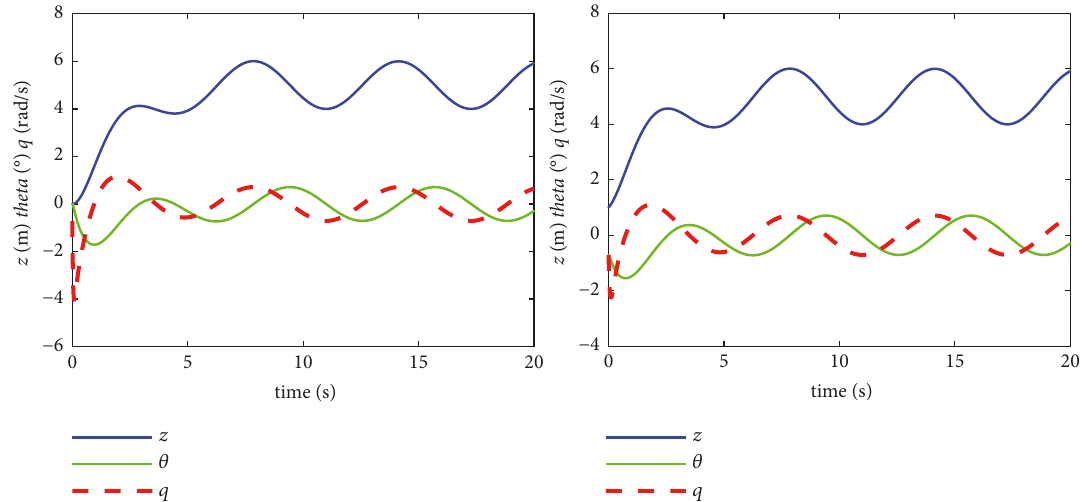
Figure 3: The AUV vertical plane system states [𝑧,𝜃, 𝑞] in the entire simulation interval.